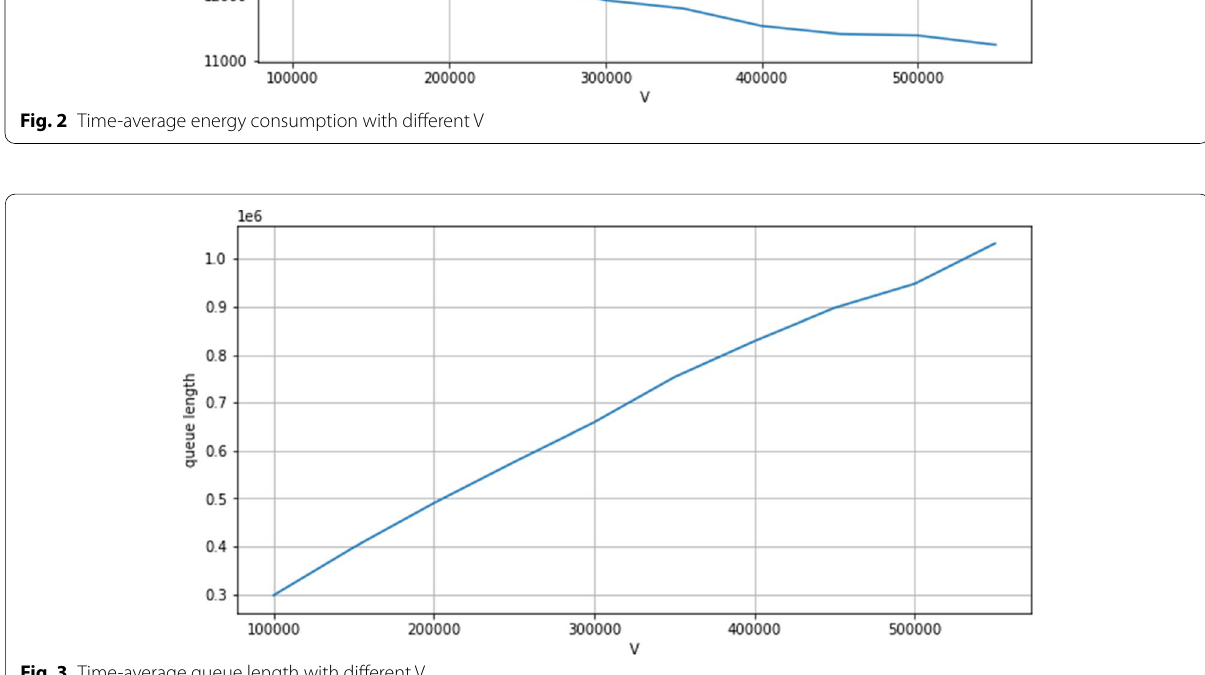
Fig. 3 Time-average queue length with different V